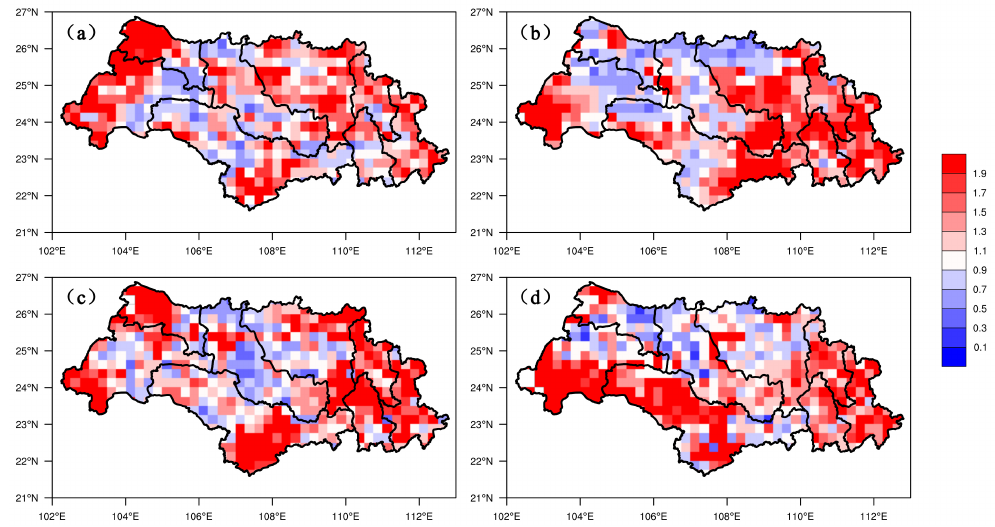
Figure 11. Study region maps showing the spatial distribution of Bias ( ≥ 20 mm/day) in the Xijiang Basin. ( a ) 24 h lead time; ( b ) 48 h lead time; ( c ) 72 h lead time; ( d ) 96 h lead time.